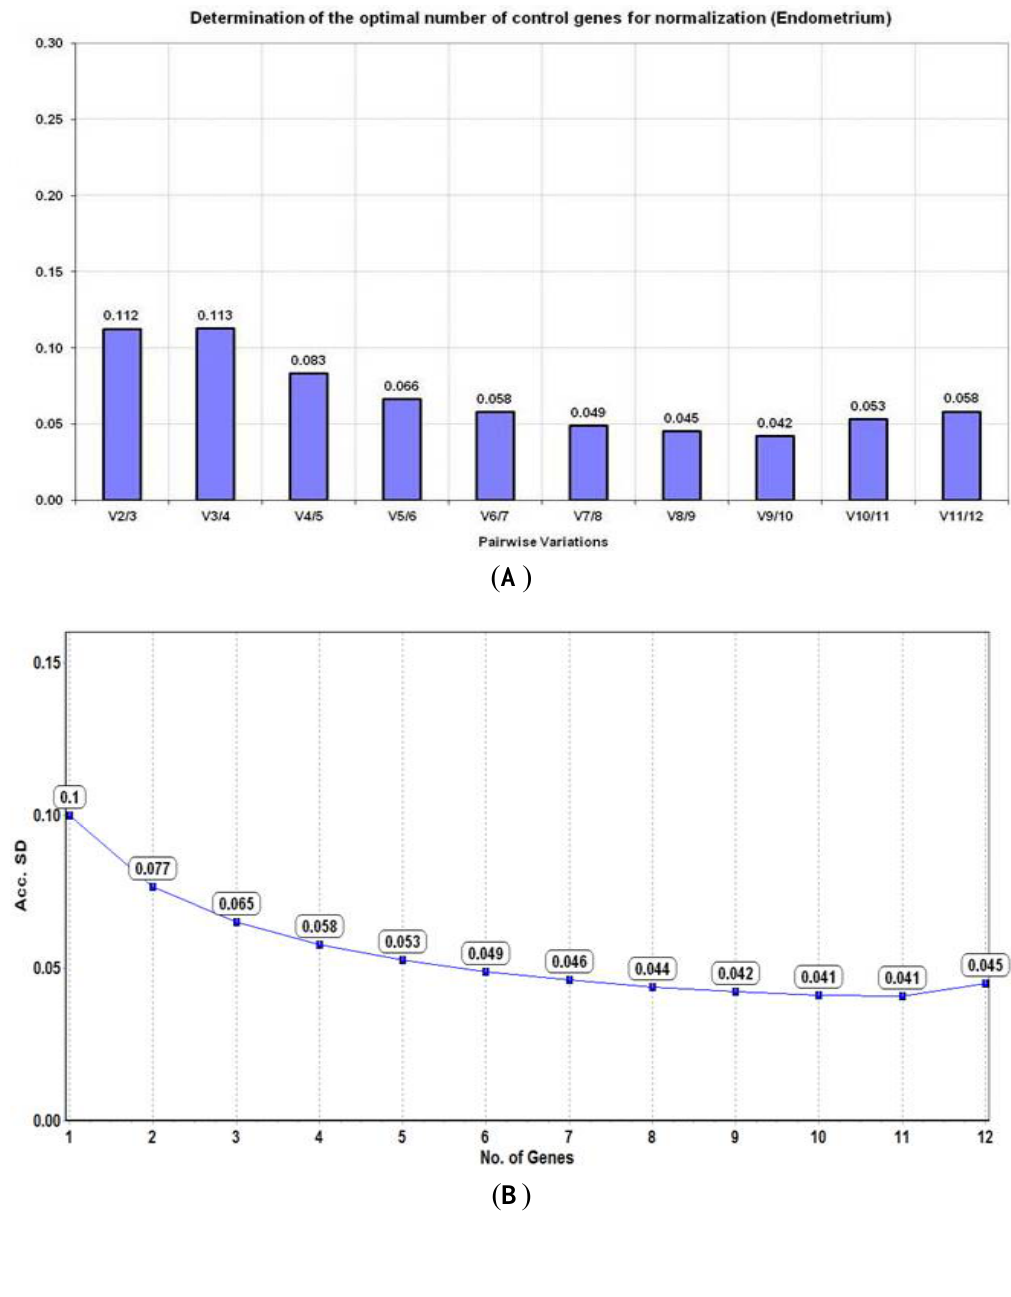
Pairwise variation calculated by geNorm indicated that the combination of the top two reference genes in the endometrium i.e. , UBC and YWHAZ were stable enough to be used for normalisation without the addition of a 3rd gene (V = 0.112) (Figure 4). Although this was acceptable (V ≤ 0.15), the 2/3 lowest pairwise variation score was obtained with a combination of 10 candidate genes (V = 0.042). 9/10 Figure 4. Determination of the optimal number of reference genes for normalisation in the endometrium ( n = 12) based on their ( A ) pairwise variation (V) analysis using the geNorm algorithm and ( B ) accumulated standard deviation (Acc. SD) using the NormFinder